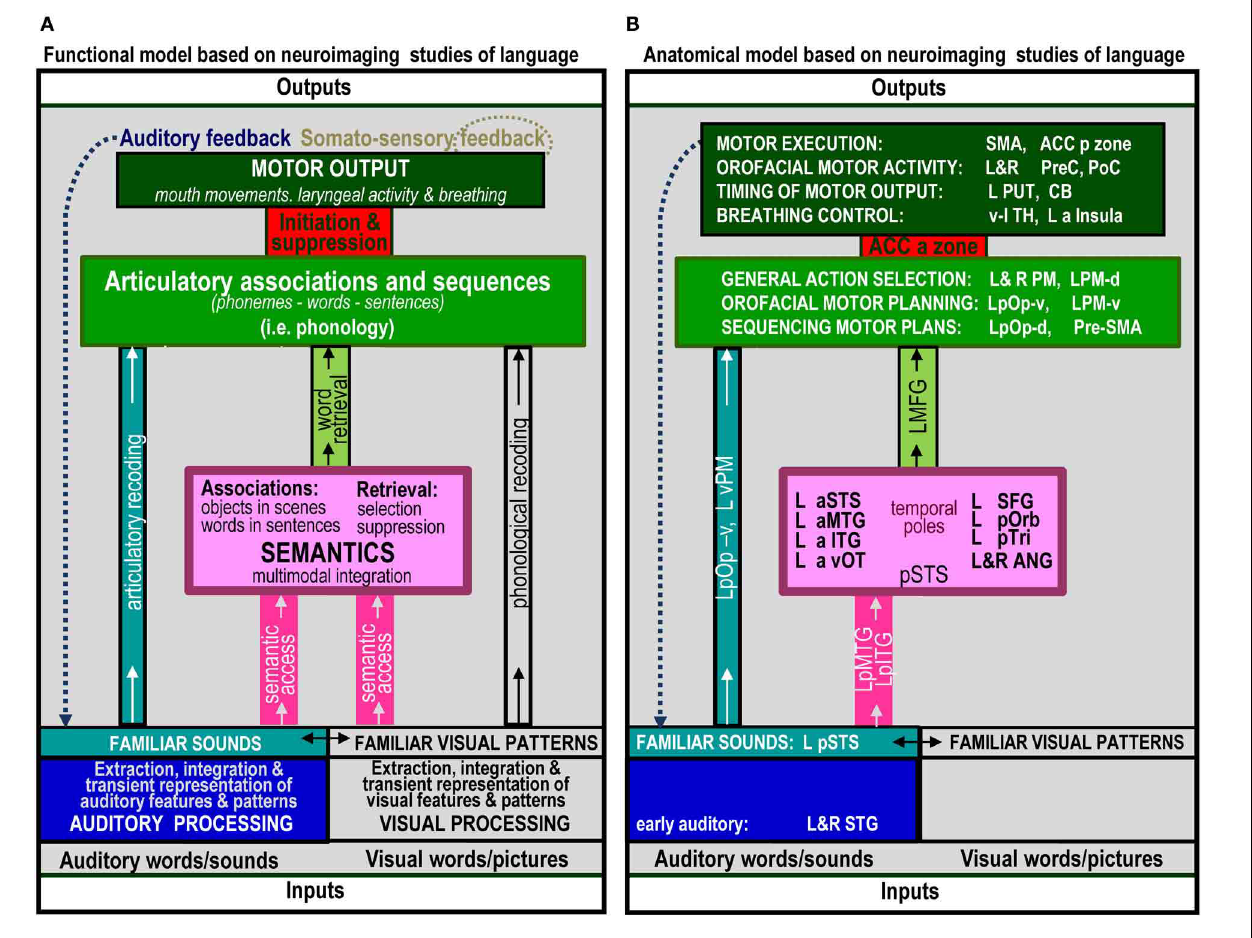
FIGURE 1 | The functional anatomy of auditory word repetition, based on an anatomical model of language in Price (2012) inspired by a review of hundreds of fMRI experiments. Parts that are not related to processes